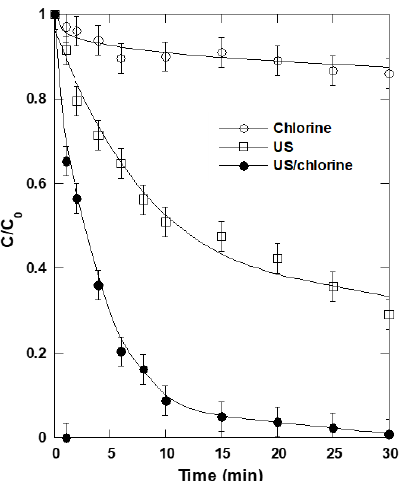
Figure 2. ARAC degradation kinetics via chlorine, ultrasound (US) and US/chlorine processes (conditions: C 0 = 5 mg · L − 1 (10 µ M), [chlorine] 0 = 250 µ M, V = 150 mL, pH 5.5, temperature: 25 ± 1 ◦ C, frequency: 600 kHz, power: 120 W).